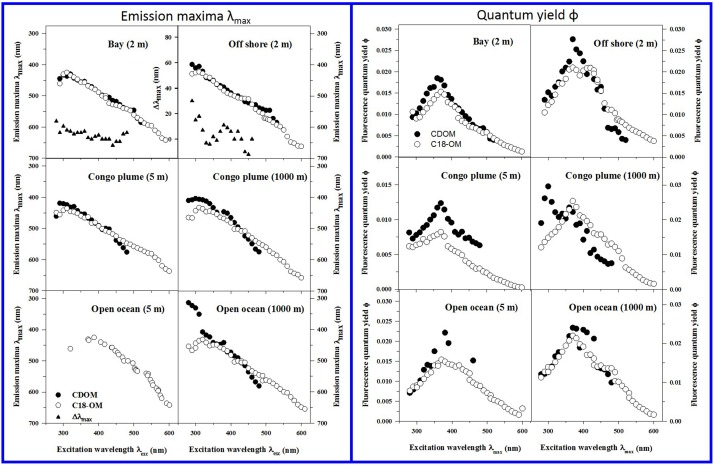
Corrected fluorescence emission maxima (left panels) and quantum yields (right panels) for representative CDOM (solid symbols) and C18-OM (open symbols) samples from MAB bay and offshore, Congo plume, and open ocean waters. Emission maxima for CDOM open ocean (5 m) could not be determined due to high signal-to-noise in emission spectra. Emission maxima plots for Bay and Offshore samples also include Δλmax plots; Δλmax > 0, indicates a red shift in λmax for C18-OM relative to CDOM.